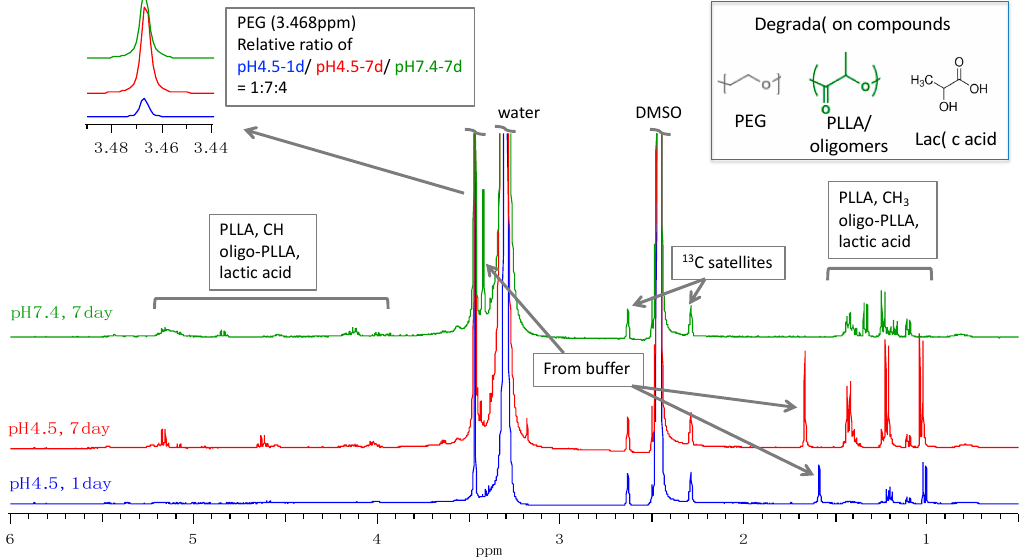
Figure 10. 1 H NMR spectra of the lyophilized supernatants from the samples: pH 4.5, after 1 day ( blue ), pH 4.5, after 7 day ( red ), and pH 7.4, after 7days ( green ).